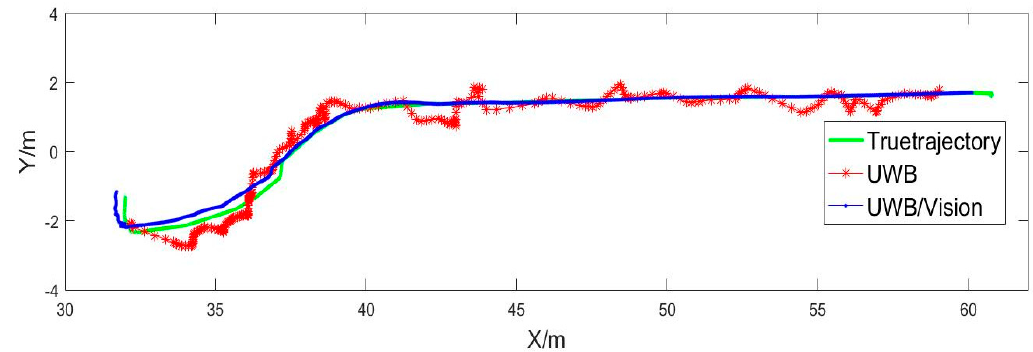
Figure 14. The positioning results.